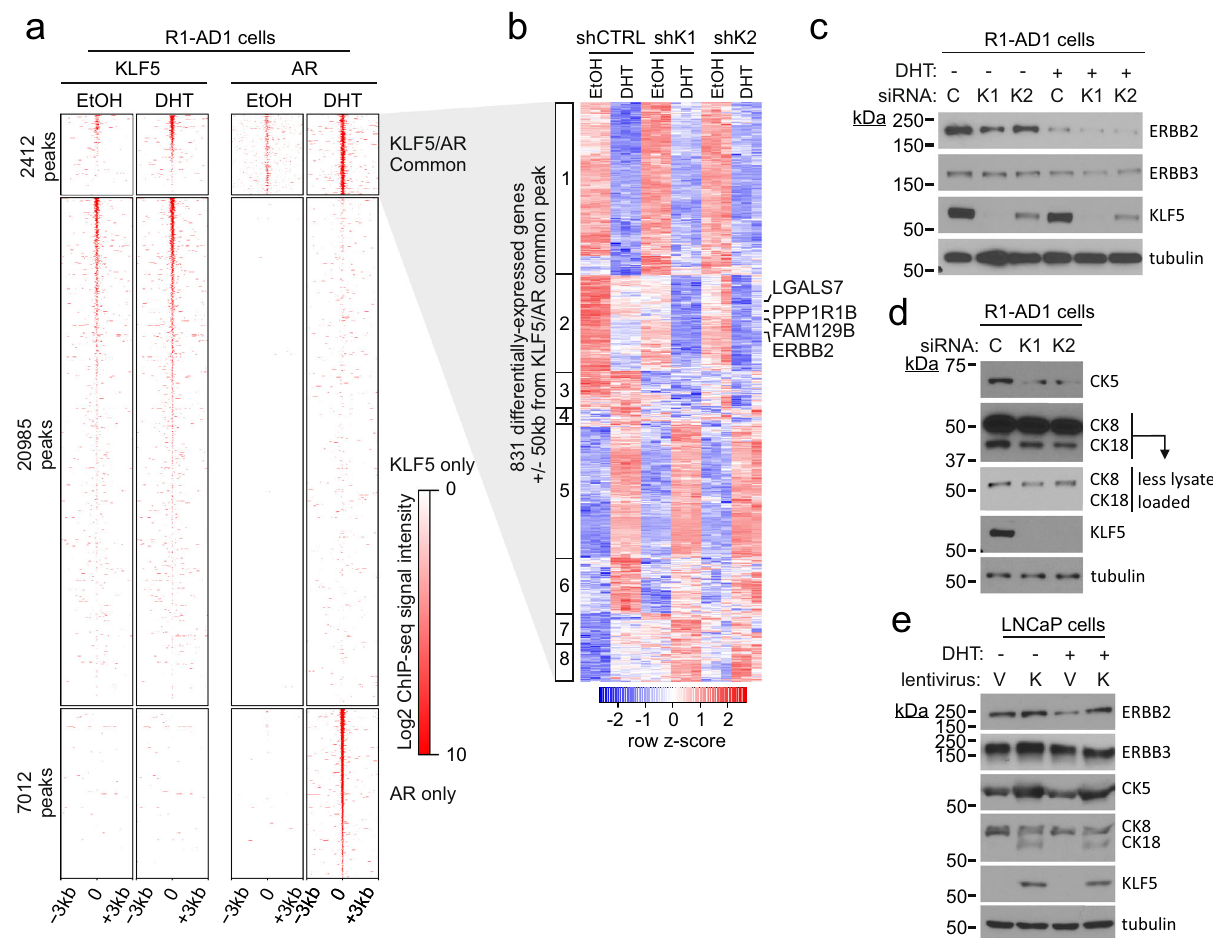
Fig. 6 Transcriptional opposition of AR and KLF5 converges at ErbB pathway genes and basal-luminal cell markers. a Heatmaps of AR and KLF5 ChIP- seq signals ±3 kb around KLF5/AR common, KLF5 only, or AR only peaks in R1-AD1 cells cultured in an androgen-deplete medium treated 4 h with 1 nM DHT or vehicle control (ethanol, EtOH). b Heatmap of RNA-seq gene expression data for a set of 831 genes located ±50 kb from a KLF5/AR common peak and differentially expressed in R1-AD1 cells based on comparisons between shRNA control (shCTRL) vs. shKLF5 conditions and/or DHT vs. vehicle conditions. The heatmap was generated by unsupervised clustering, revealing eight main clusters. c Proteins measured by western blot in R1-AD1 cells transfected with KLF5-targeted siRNAs (siK1 and siK2) or control siRNA (siC) were cultured in androgen-deplete medium supplemented with 1 nM DHT or vehicle control (EtOH). Tubulin is a loading control. One additional replicate experiment was performed that yielded a comparable result. d Cytokeratin-5 (CK5), cytokeratin 8/18 (CK8/18), and KLF5 proteins measured by western blot in R1-AD1 cells transfected with siRNAs as in c . Tubulin is a loading control. One additional replicate experiment was performed that yielded a comparable result. e Proteins measured by western blot in LNCaP cells infected with lentivirus encoding KLF5 or empty vector and cultured in an androgen-deplete medium supplemented with 1 nM DHT or vehicle control (EtOH). Tubulin is a loading control. One additional replicate experiment was performed that yielded a comparable